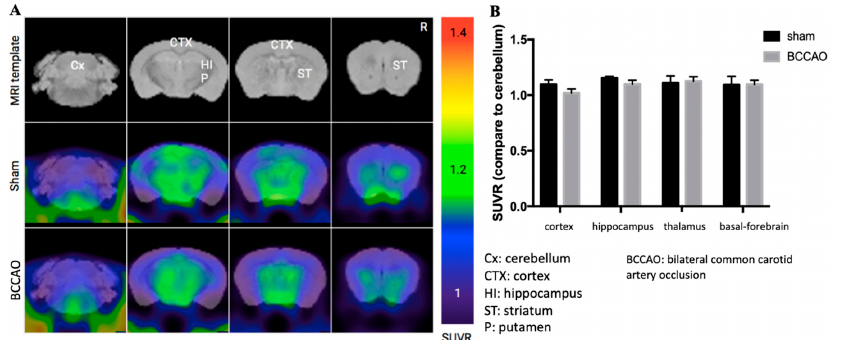
Figure 2. Chronic cerebral hypoperfusion induced by modified bilateral common carotid artery occlusion (BCCAO) did not cause amyloid-beta accumulation after 3 months. ( A ) Amyloid positron imaging tomography scan image. ( B ) Quantification data of A β accumulation were same for sham and BCCAO mice in some brain regions. n = 6 for each group. Data are presented as the mean ± standard deviation based on one-way analysis of variance.